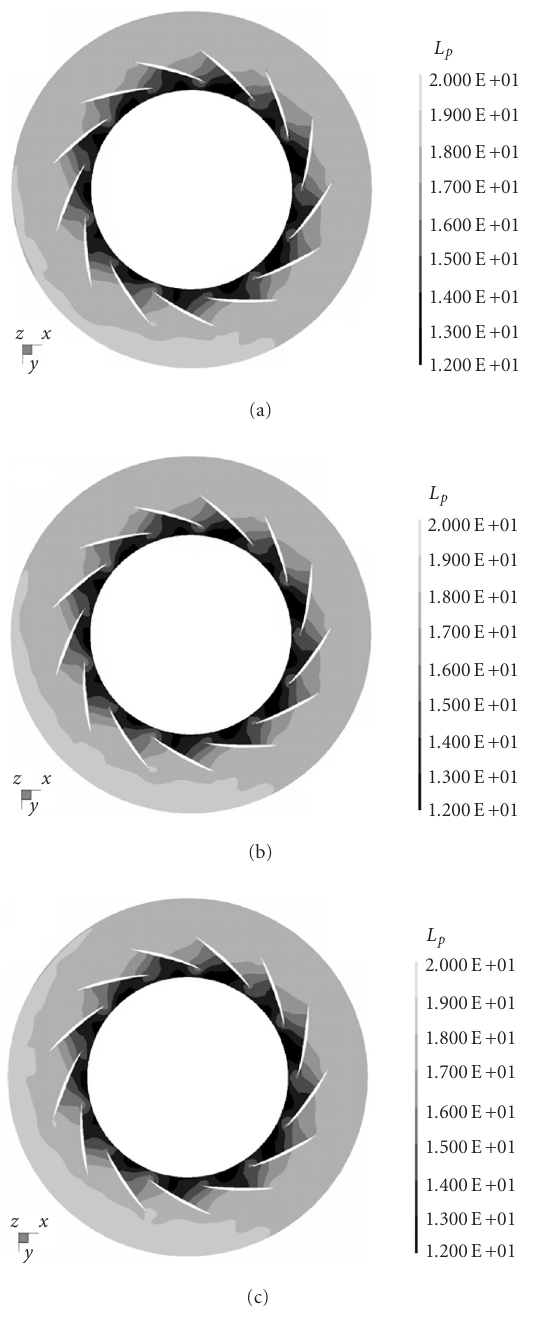
Figure 17: Static pressure on the di ff user center plane for the vane- less case at near-surge conditions: (a) starting position, (b) 1 / 3 rev- olution, and (c) 2 / 3